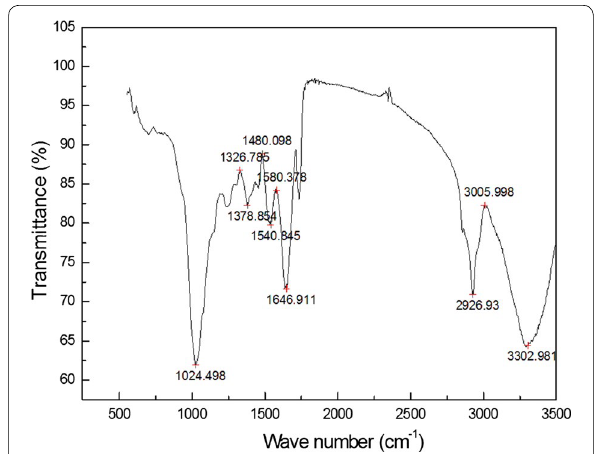
Fig. 5 The FT IR spectrum of activated sludge